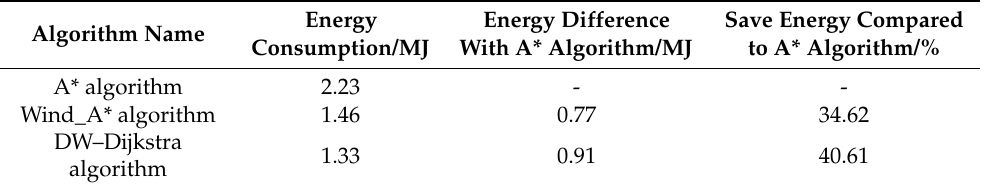
Table 2. Comparison of simulation energy consumption of three algorithms in an artificial wind field.